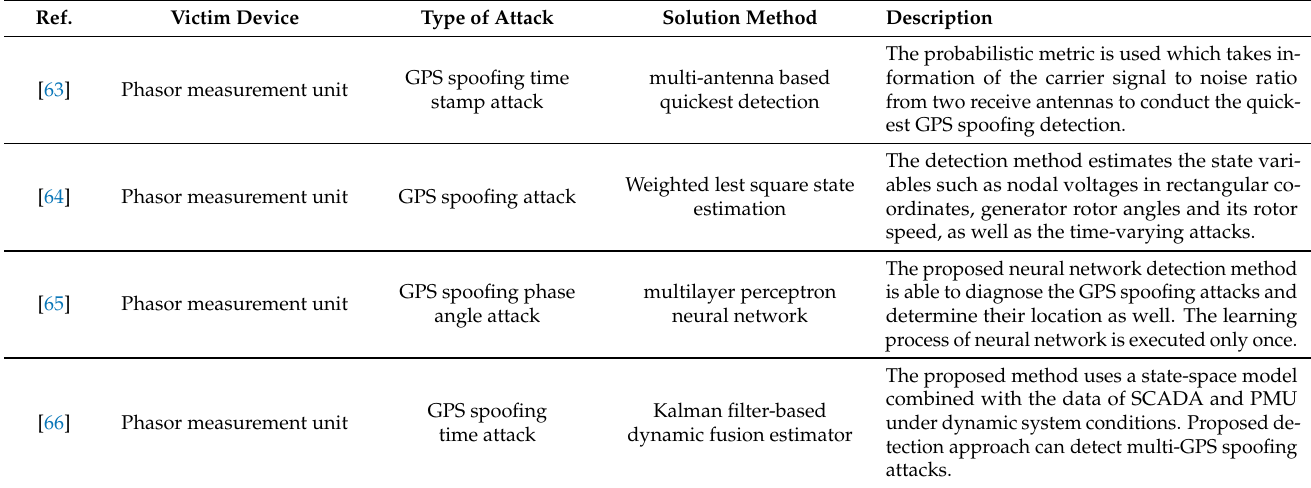
Table 4. Review of spoofing attacks detection in smart grid